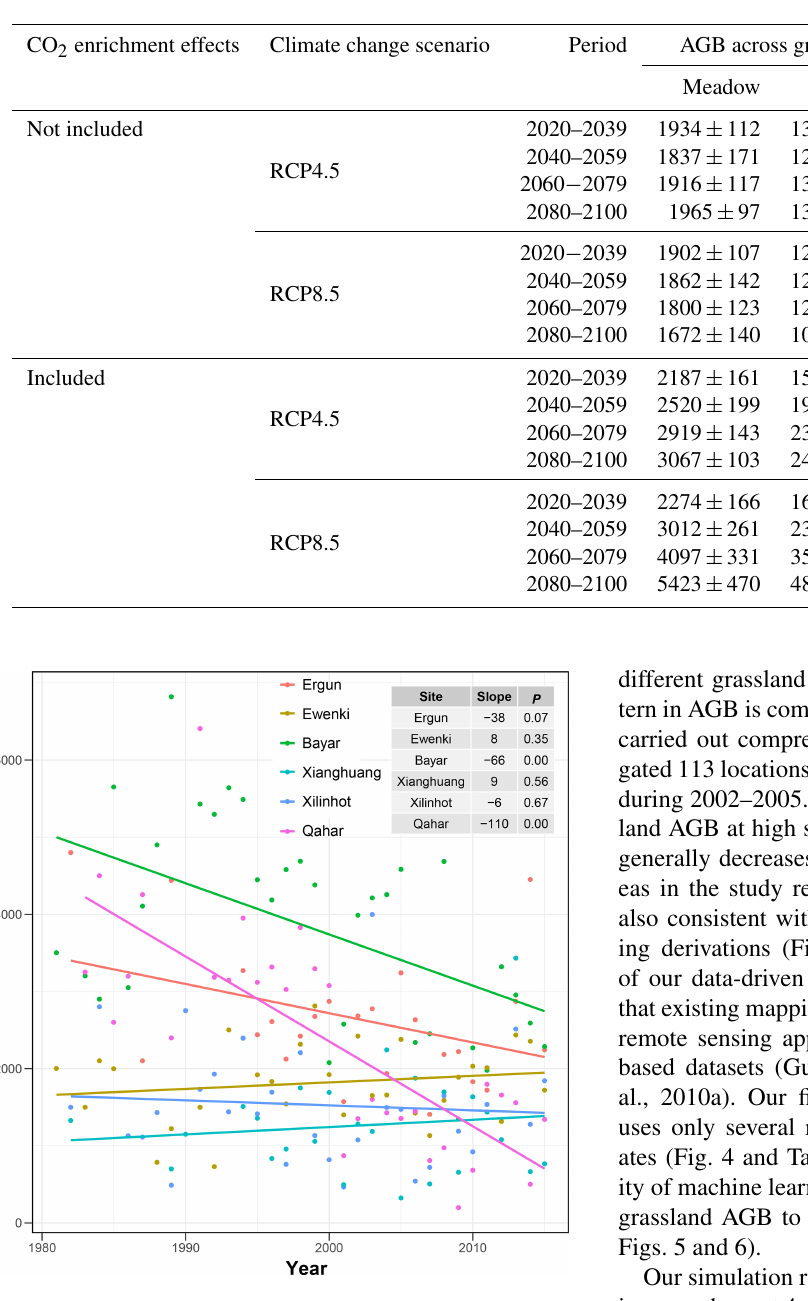
Figure 7. Temporal changes in aboveground biomass (AGB) in the six long-term filed experiments in Inner Mongolian grasslands. The table inside shows the linear trends (slope, kgha − 1 yr − 1 ) in AGB and the significance (reflected by P